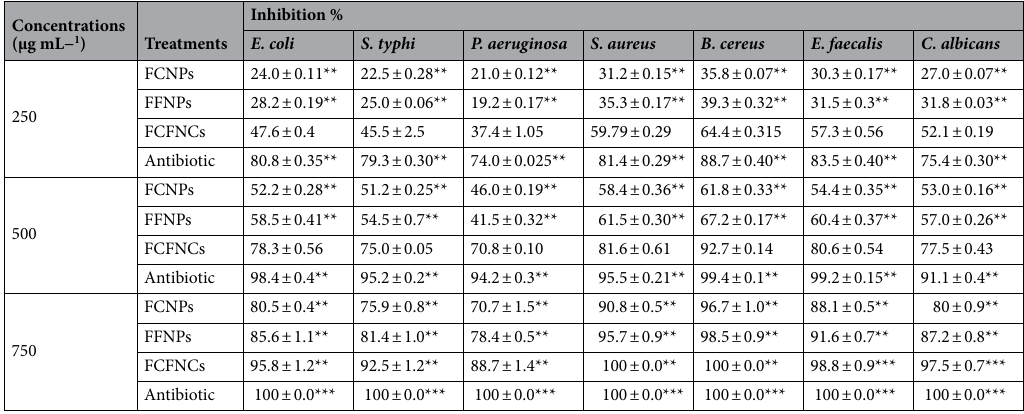
Table 2. The antagonistic efficiency of FCNPs, FFNPs, FCFNCs and antibiotics (tetracycline for bacteria and nystatin for yeast) at 250, 500 and 750 µg mL −1 against planktonic prokaryotic and eukaryotic pathogens. All values were expressed as mean ± SEM. FCFNCs were compared with all other treatments, at each concentration, with significance at *p < 0.05, **p < 0.005, ***p < 0.0005.